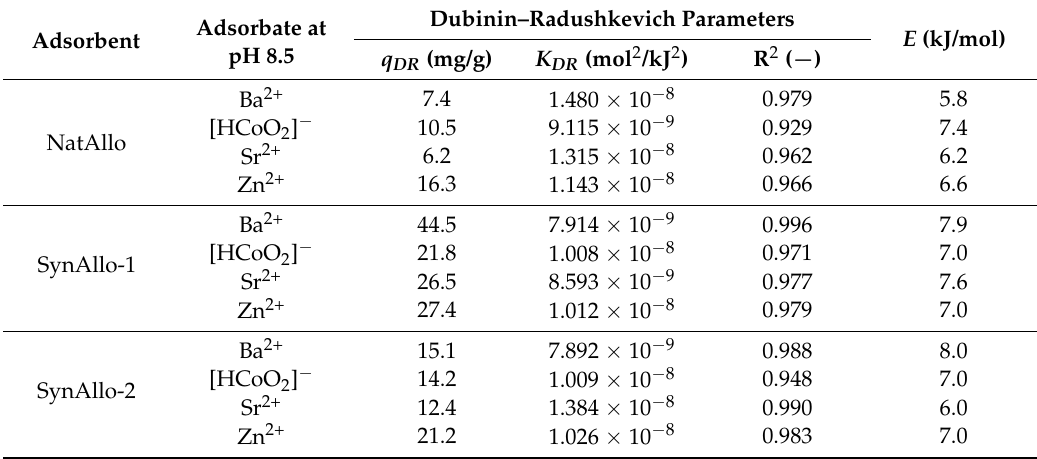
Table 3. Dubinin–Radushkevich parameters and mean free energy change ( E ) for the adsorption of aqueous Ba, Co, Sr, and Zn on natural and synthetic